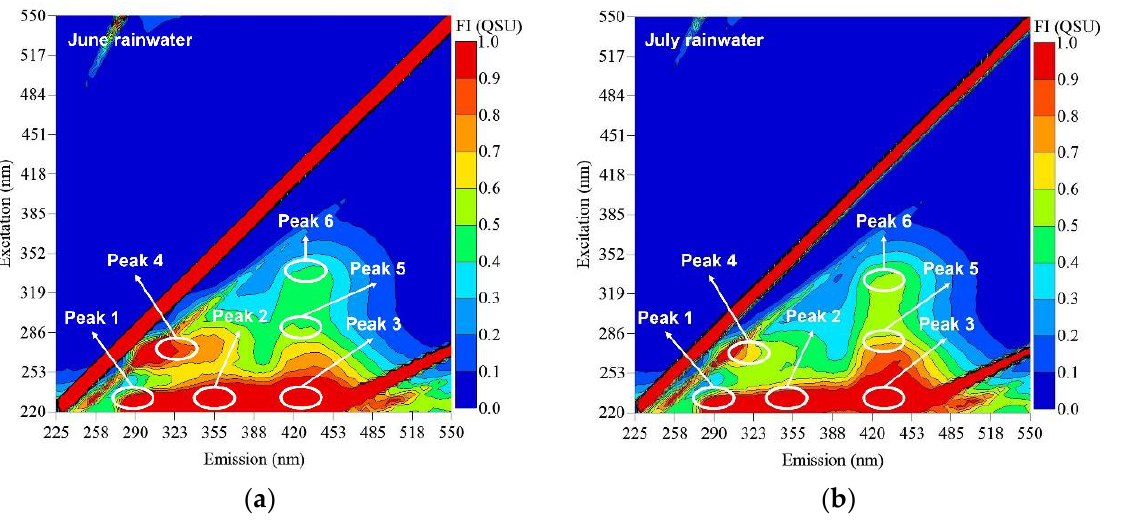
Figure 2. Fluorescence spectra of rainwater from different sampling periods ( a ) June ( b ) July. Peak 1: protein-like tyrosine; Peak 2 and 4: protein-like tryptophan; Peak 3: fulvic acid-like; Peak 5: marine humic-like; and Peak 6: humic-like from fluorescence EEM.